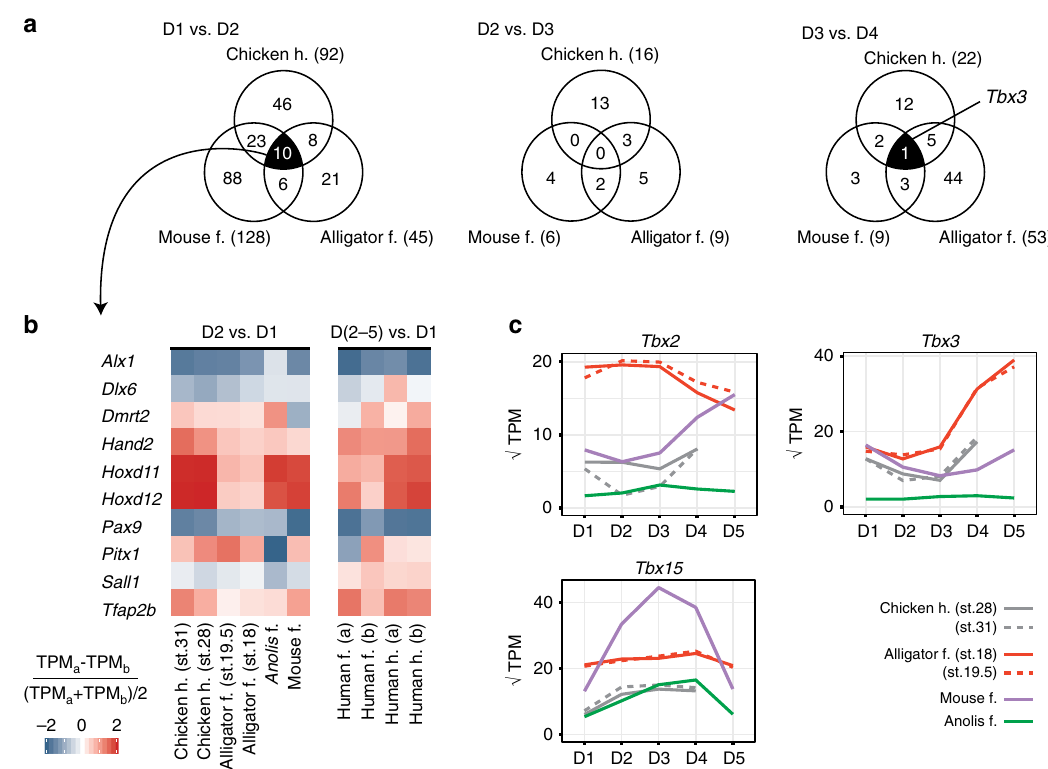
Fig. 4 D1 has a unique, conserved gene expression pro fi le across amniotes. a Venn diagrams of one-to-one orthologous transcription factors genes of mouse, alligator, and chicken that are differentially expressed between adjacent digits (FDR threshold of 0.05). b Heatmap showing relative expression of genes in D2 and D1. Human transcriptomic data provides additional support for the hypothesis that D1 has a conserved developmental identity across amniotes. c Expression levels of T-box family genes across the autopod. Transcript per million (TPM) values presented in panels b and c calculated from the gene list of one-to-one orthologous genes between mouse, alligator, Anolis , chicken, and human. Source data for panels b and c are provided as a Source Data fi